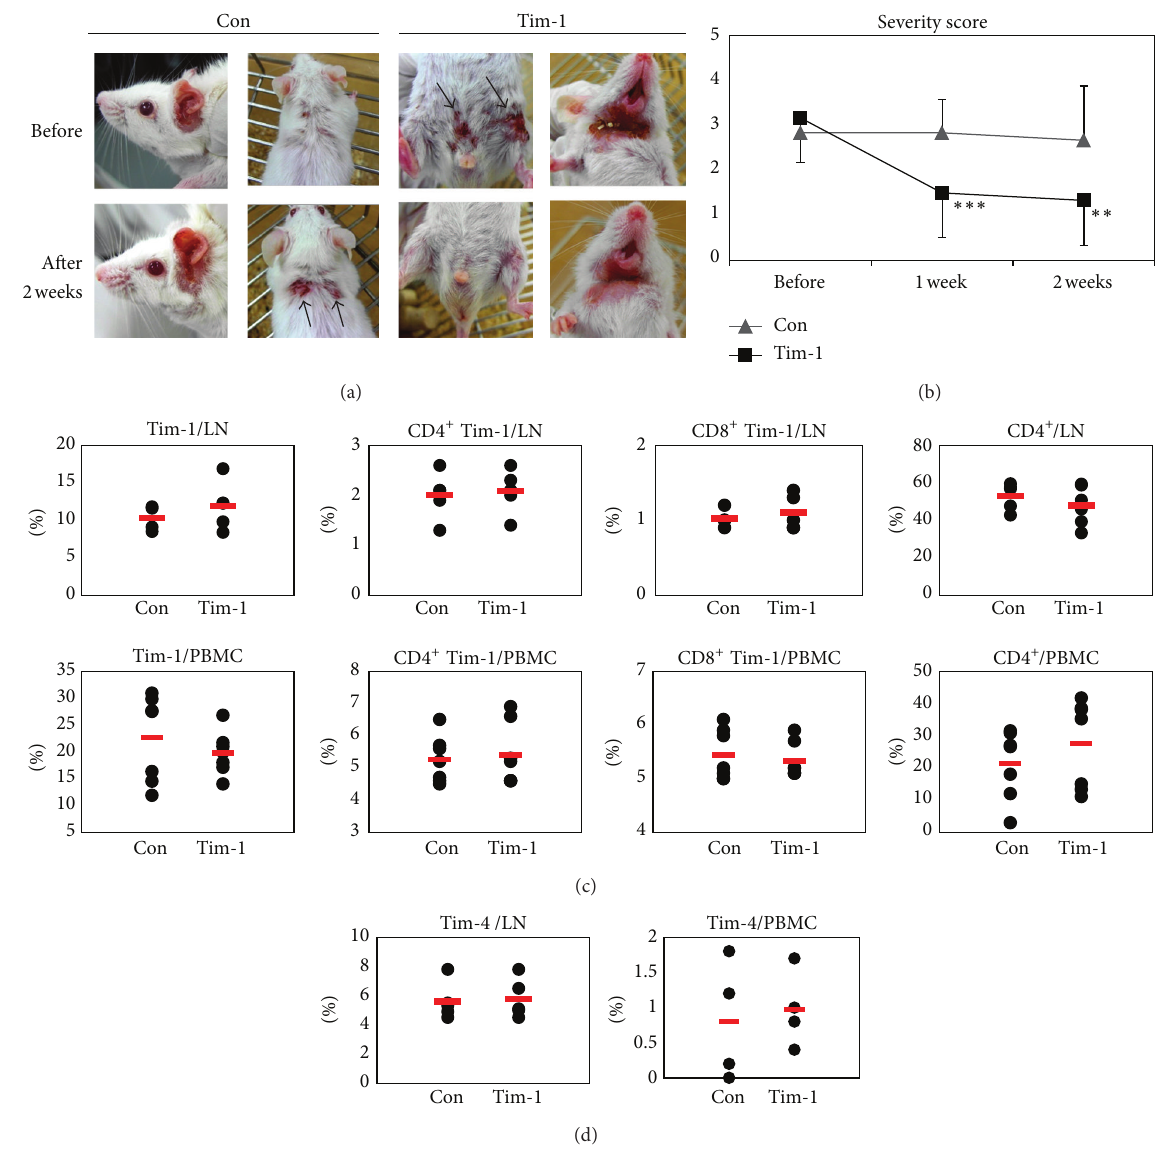
Figure 4: Administration of Tim-1 improved the Behc¸et’s disease (BD)-like symptoms, but the frequencies of Tim-1 expressing cells remained unchanged. Ten 𝜇 g/mouse of Tim-1 vector was injected intraperitoneally four times at 2 day intervals into BD mice, followed by 2 weeks of observations. (a) Photographs of mice were taken before and at 1 and 2 weeks after the first treatment of the Tim-1 vector and control vector injected groups. (b) Severity scores were compared before and at 1 and 2 weeks after treatment. (c) Two weeks after first Tim-1 vector injection, the frequencies of Tim-1 + , CD4 + Tim-1 + , CD8 + Tim-1 + , CD4 + T cells, and (d) Tim-4 + cells in LN and PBMCs were evaluated by FACS analysis ( 𝑛 = 5-6) ( ∗ 𝑃 < 0.1 ). Con: control vector injection to BD mice, Tim-1: Tim-1 vector injection to BD